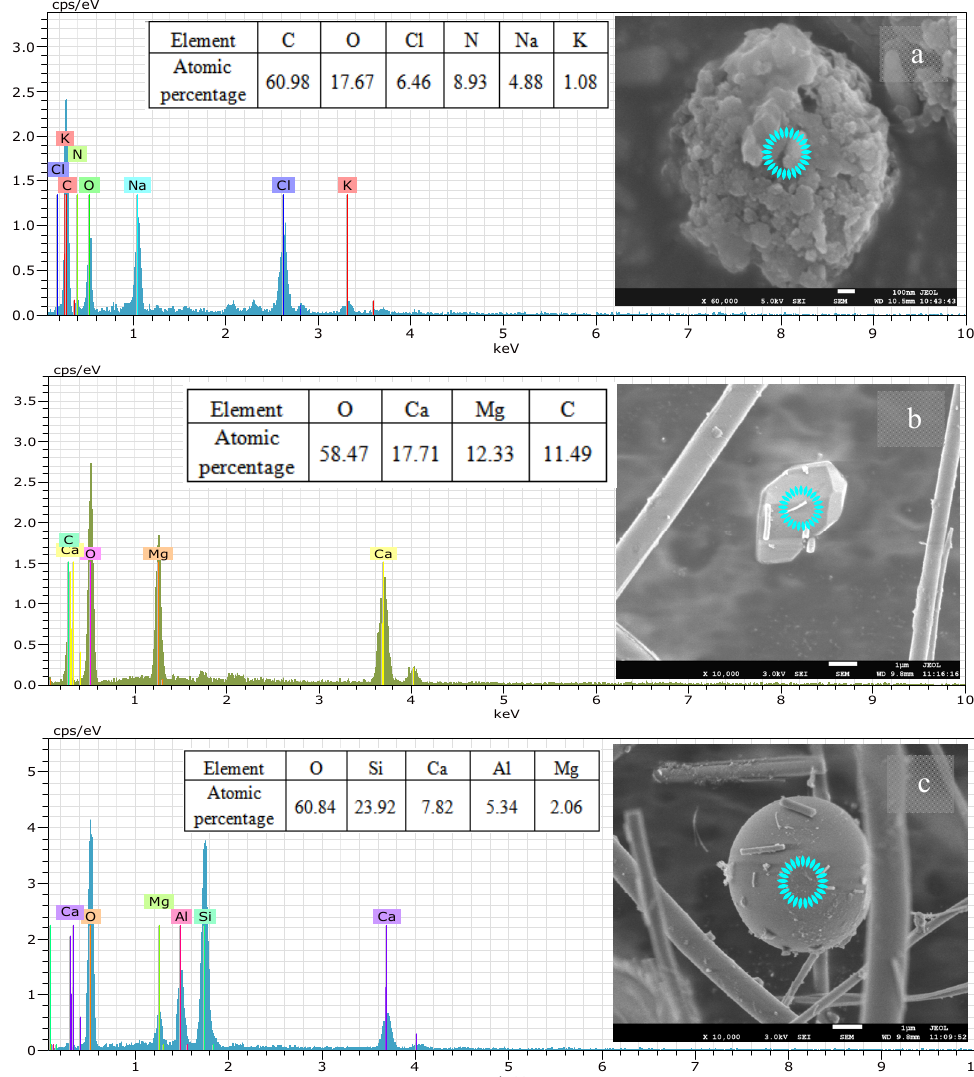
Figure 7. Element analysis of atmospheric particles in PM 2.5 at Wutai Mount scenic spot (( a ) in the Wu Ye Temple sampling point; ( b ) in the Manjusri Temple sampling point; ( c ) in the Wu Ye Temple sampling